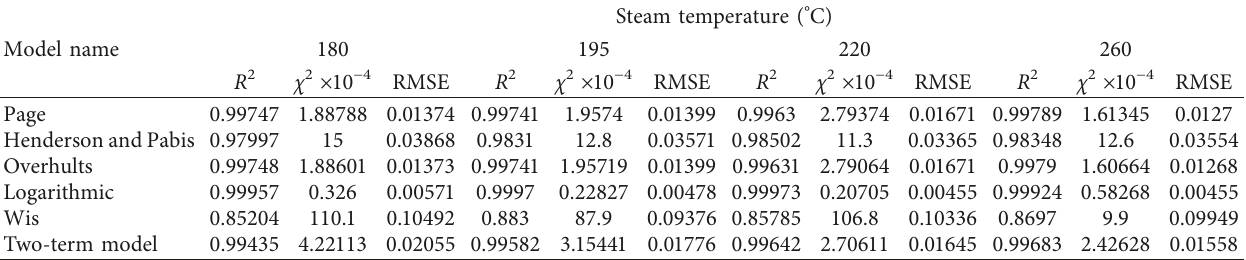
Table 5: Fitting results of drying stage of sludge superheated steam drying under different steam temperature.